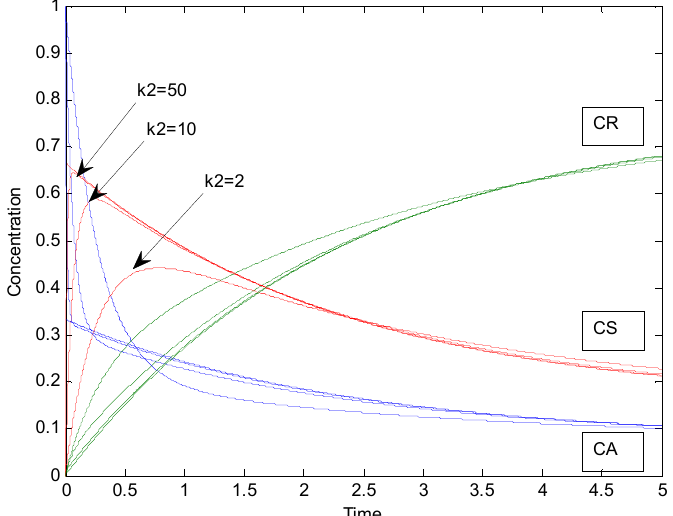
Figure 8. Concentration profiles of the general case of a parallel reaction system with parameters: k 1 = 1, k 2 = 2, 10 and 50, K 1 = 10 and K 2 = 2.